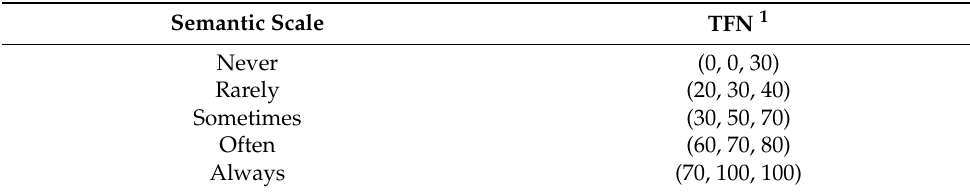
Table 2. 5-point semantic scale conversion to